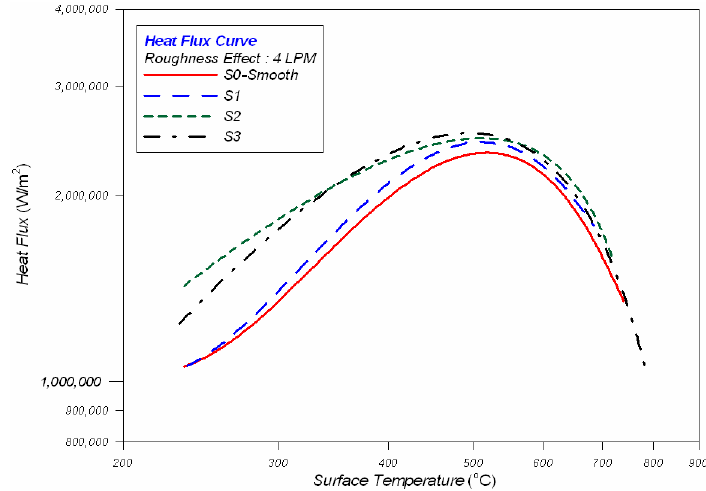
Fig. 8 Heat flux curve at 4